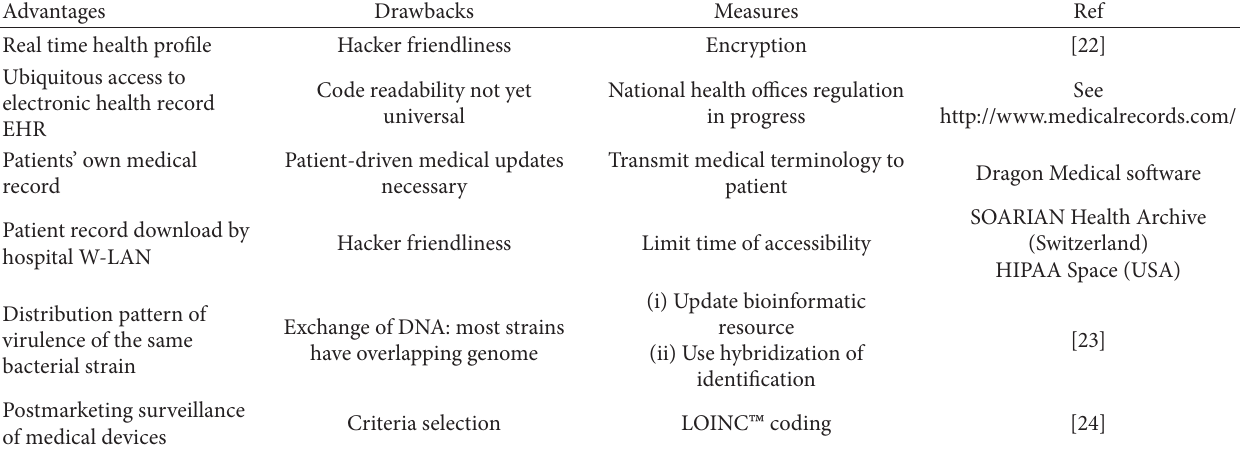
Table 2: Big data in electronic health records (EHR). A 2016 update with special emphasis on medical laboratory